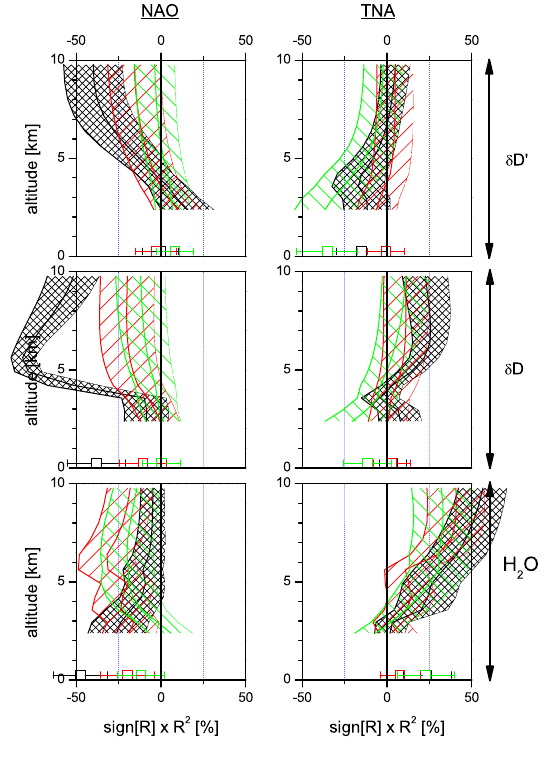
Fig. 15. Same as Fig. 13 but for Iza˜na and for correlations with the NAO and TNA